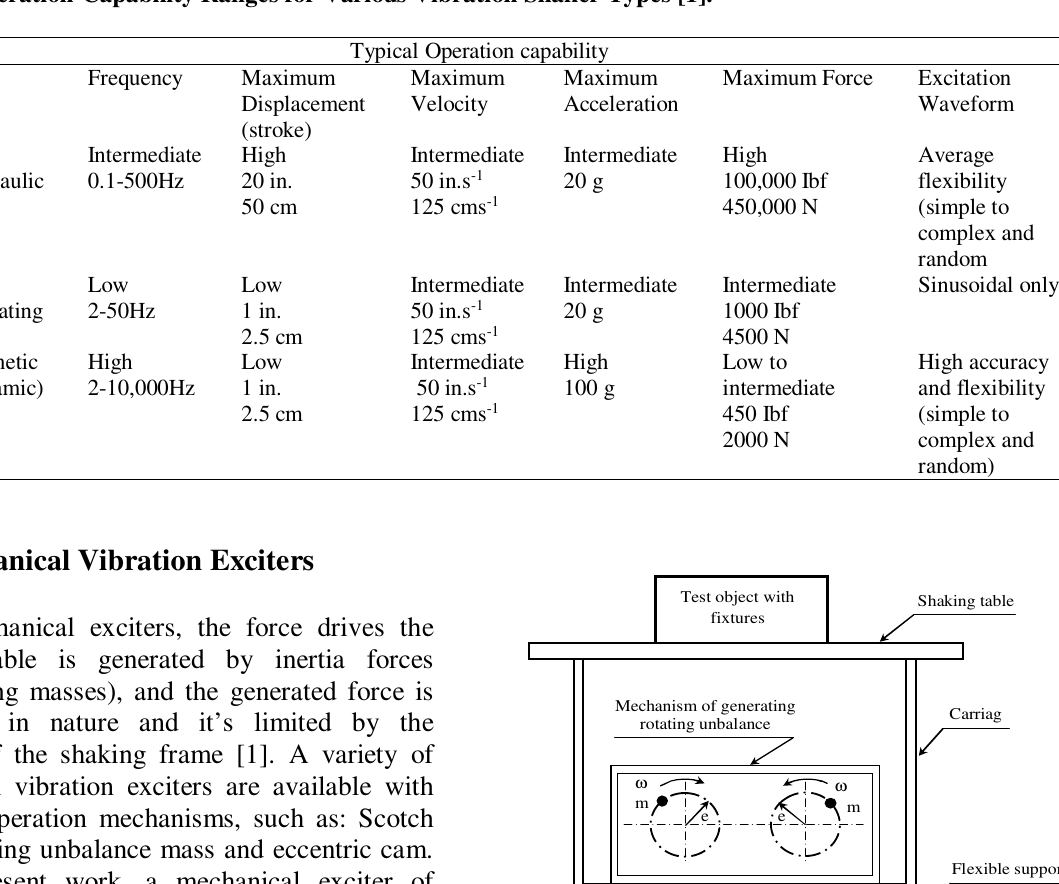
Typical Operation-Capability Ranges for Various Vibration Shaker Types [1].